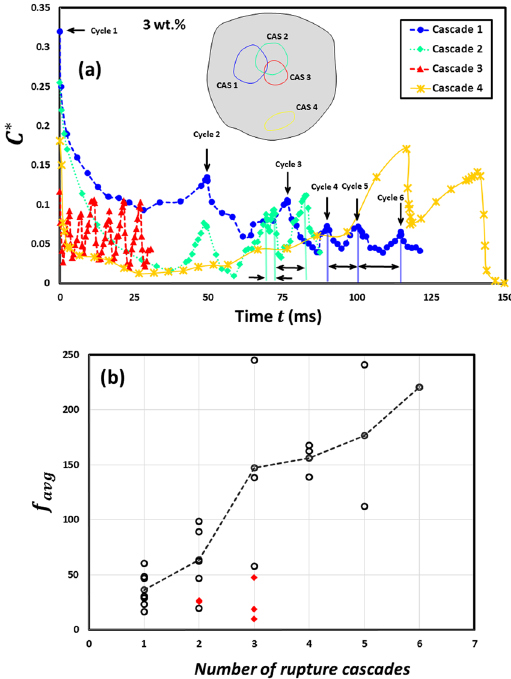
Figure 6. Time evolution of global oscillatory response parameters for a 3 wt.% gelled ethanol fuel droplet undergoing burning. ( a ) Variation of circumferential strain ∆ = ⁎ C C C ( / ) across different oscillatory rupture cascades. π = C A 2 ( A is projected droplet area) is the reference circumference in the deflated droplet state p p prior to onset of a rupture cascade. ( b ) Average bursting frequency = f function of cascade count.